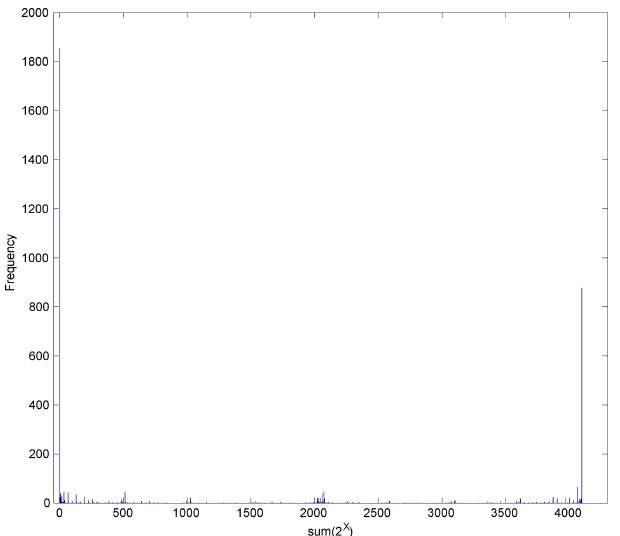
Figure 4. Frequency of the observed patterns among all the possible cases (2 12 = 4096). The x coordinate indicates each pattern with the numbering of the binary number system. All zero (0) and all one (4095) have the largest and second largest numbers of frequency as 1894 and 877, respectively, as expected meaning all dry and all wet stations. Note that the bars are very sporadic, indicating a number of occurrence patterns are not observed.